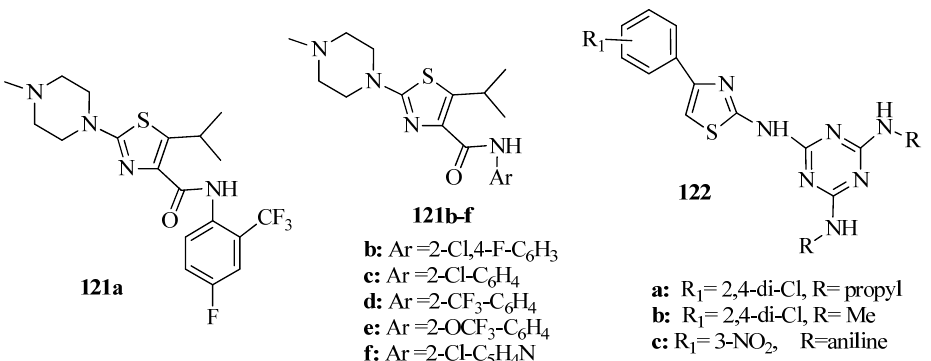
Figure 51. Structures of 5-isopropyl-2-(4-methylpiperazin-1-yl)-N-phenylthiazole-4-carboxamides and thiazole-1,3,5-triazines.